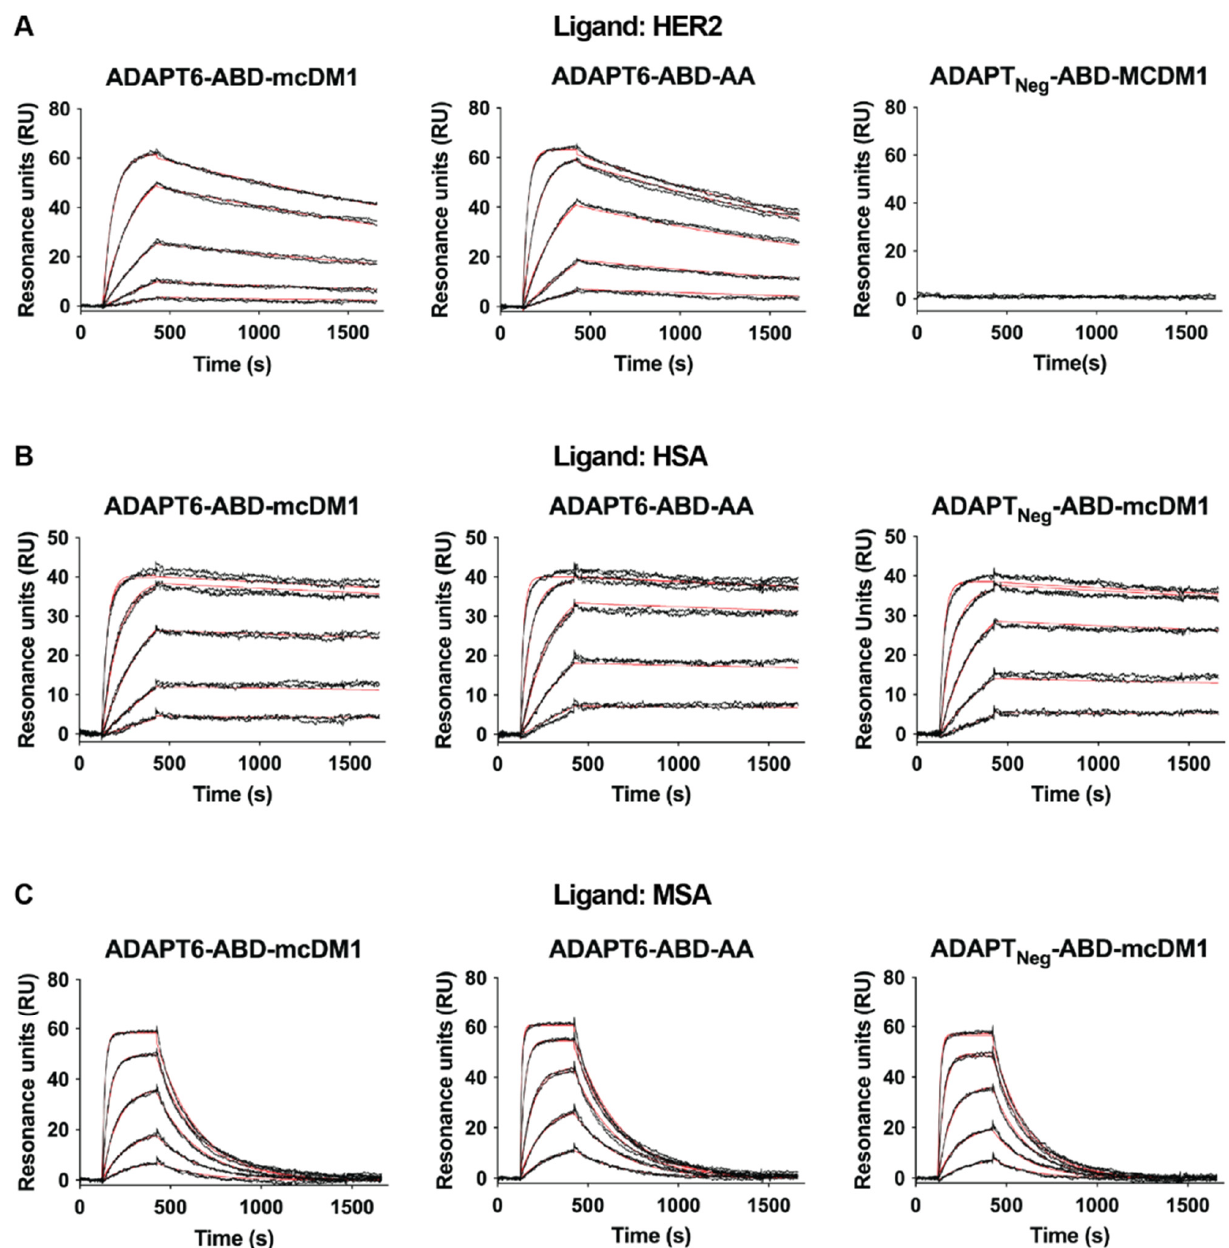
Figure 2. Analysis of the interactions between the constructs and different ligands. The analysis was conducted using a Biacore real-time biosensor instrument. Dilution series of the constructs, indicated above each paned, were injected over the chip surface with different immobilized ligands ( A ) HER2, ( B ) HSA and ( C ) MSA. The panels are overlays of the sensorgrams (in black) obtained from two identical injections for each concentration and the theoretical curves drawn using the calculated kinetic parameters for each interaction (in red).